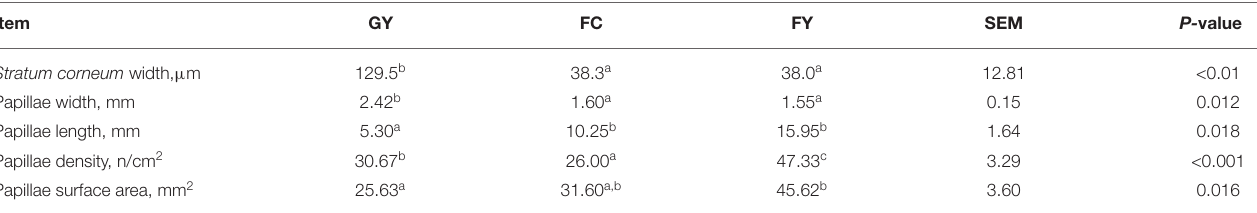
TABLE 2 | Rumen morphology of grazing yaks (GYs), feedlot-fattened cattle (FC), and feedlot-fattened yaks (FYs).